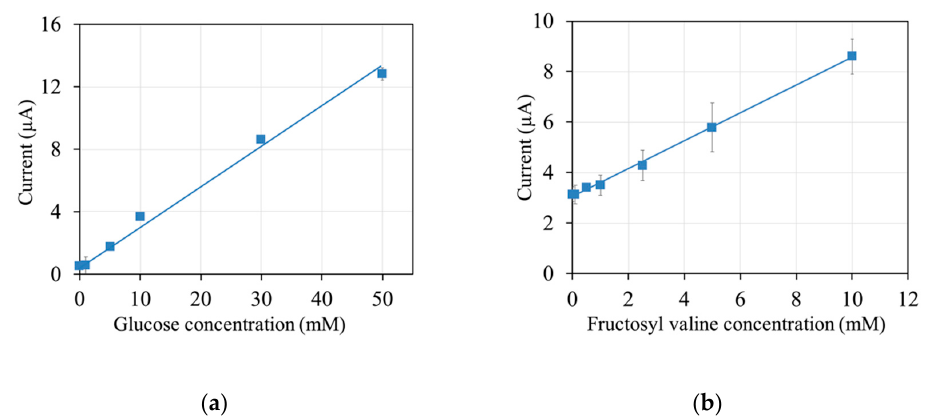
Figure 6. Calibration curves of biosensors utilizing mPES and ( a ) Af GDH CC mutant (linear regression: y = 0.25x + 0.65; R 2 = 0.99) or ( b ) Pn FPOx N56A mutant (linear regression: y = 0.55x + 3; R 2 > 0.99). Sensor composition: 0.1 U enzyme, 100 nmol mPES, 40 µ g sucrose, and 20 µ g Tween 20. Waiting time: 90 s. Applied potential: + 0.2 V vs. Ag / AgCl. N = 3. Sampling point: 10 s.